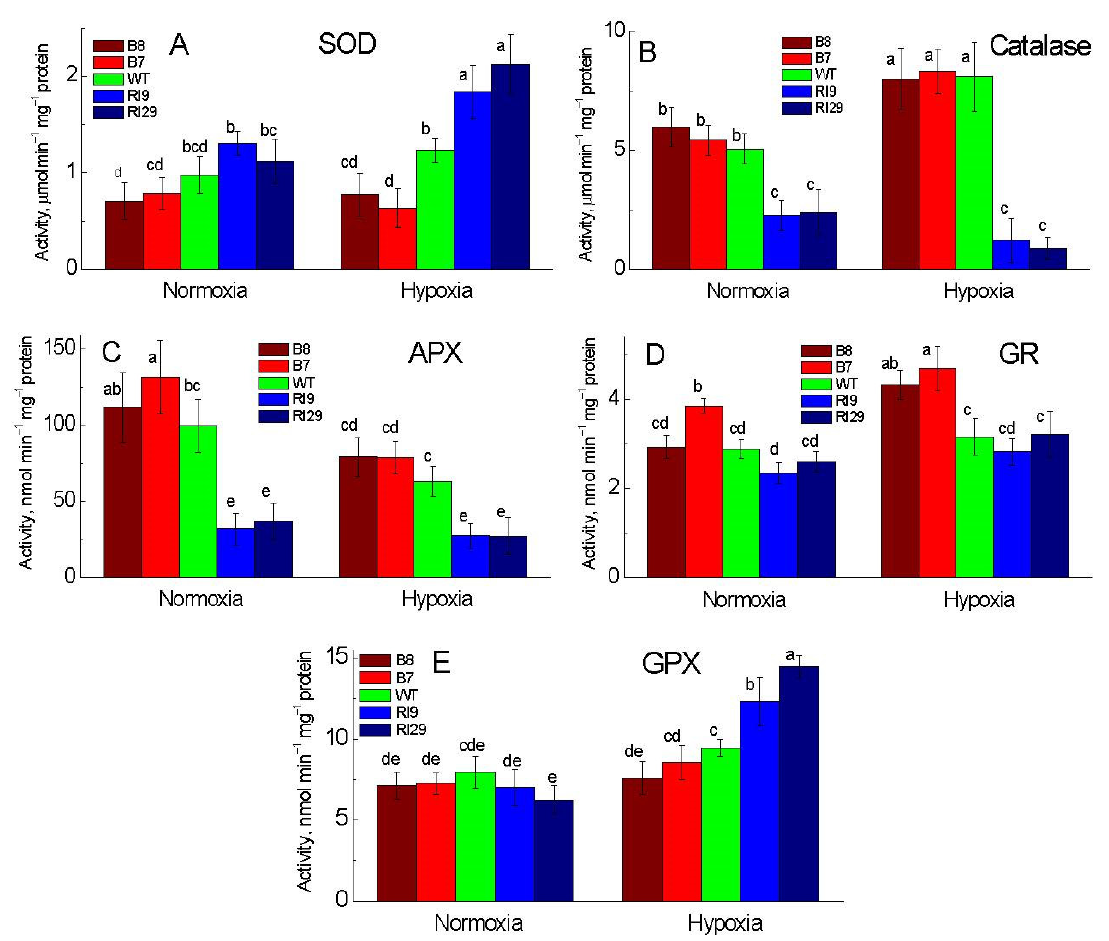
Figure 4. Activities of antioxidant enzymes in leaves of tobacco plants exposed to normoxia and 6 h hypoxia: ( A ) superoxide dismutase (SOD), ( B ) catalase; ( C ) ascorbate peroxidase (APX), ( D ) glutathione reductase (GR), and ( E ) guaiacol peroxidase (GPX). The plant lines used included the wild type (WT), two alternative oxidase overexpressors (B7 and B8), and two alternative oxidase knock- downs (RI9 and RI29). Vertical bars indicate SD from three to four independent experiments ( n = 3–4); different letters indicate significant differences between five tobacco lines and the treatments.